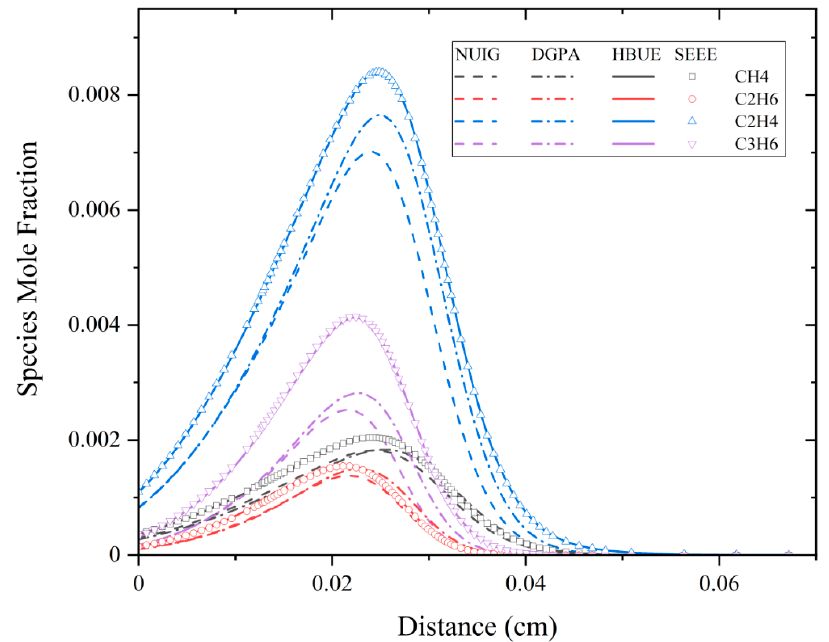
Figure 12. Comparison of the mole fraction for the key C 1 to C 3 species between NUIG, DGPA, HBUE, and SEEE for burner-stabilized flame at an equivalence ratio of 1.0 and an unburned gas temperature of 298 K.